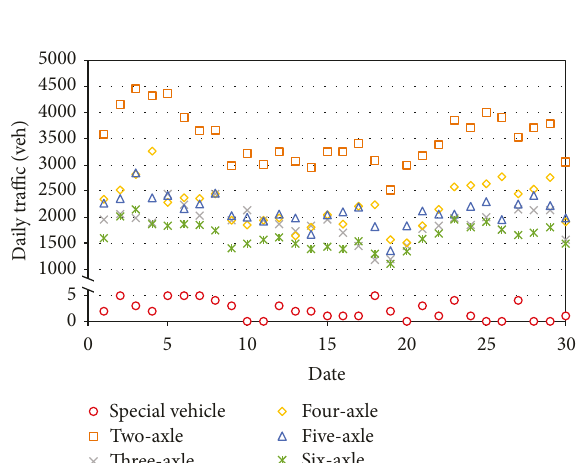
Figure 4: Daily traffic volume.